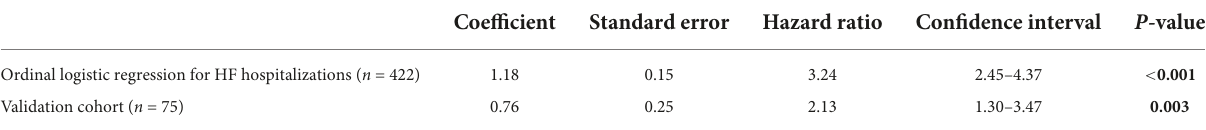
TABLE 3 Ordinal logistic regression for HF hospitalizations and validation of the HALO score.